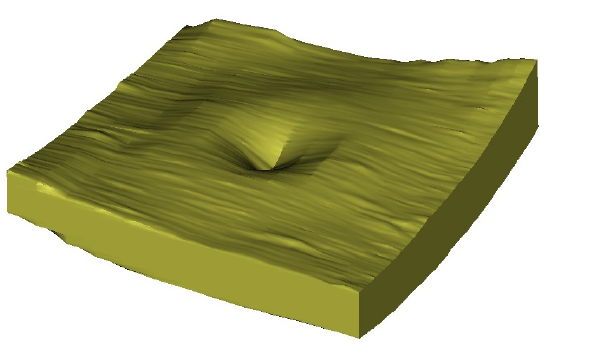
Figure 4. SLO and OCT images from the healthy eye of Patient 1.